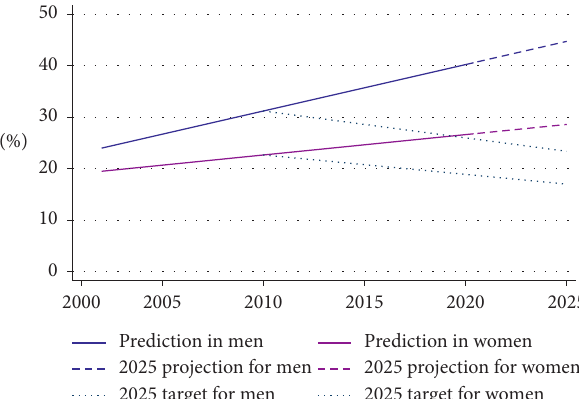
Figure 4: Prediction of hypertension and a 25% reduction target by